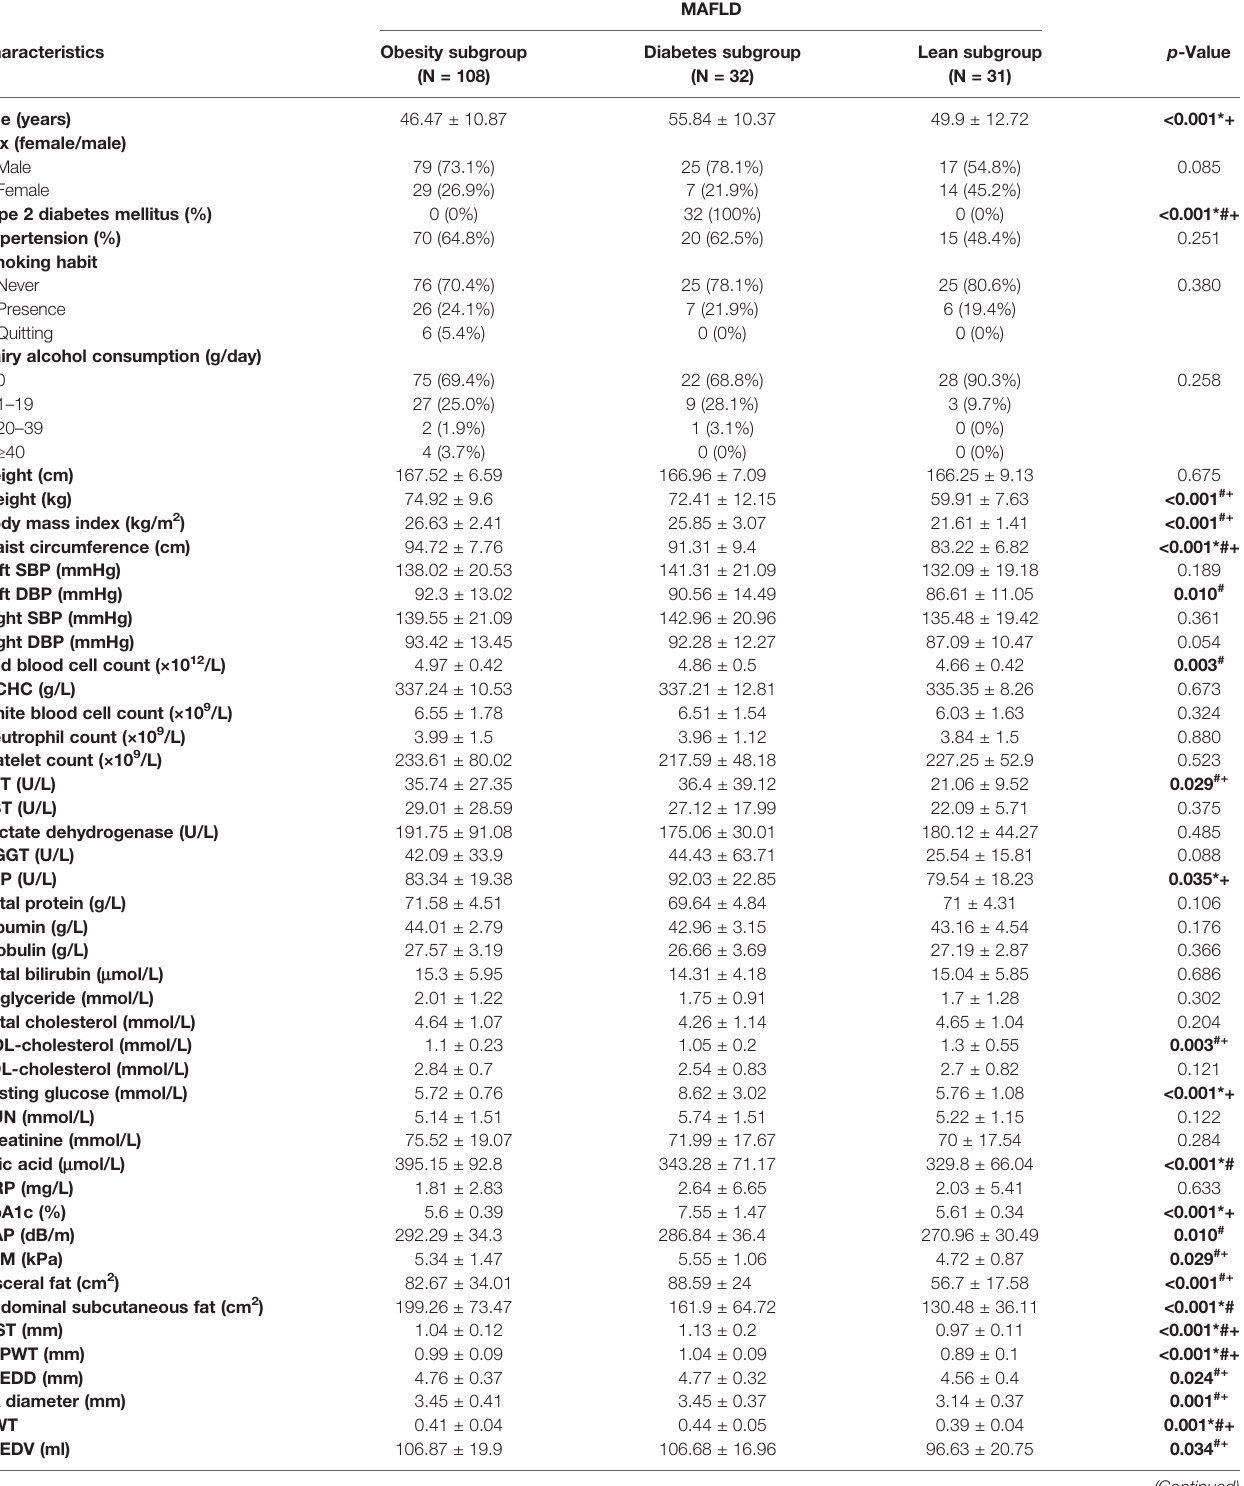
TABLE 3 | Characteristics of different MAFLD